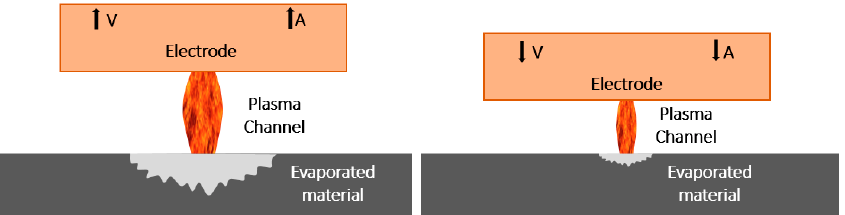
Figure 5. Graphical representation of the influence of machining parameters on the amount of evaporated material.